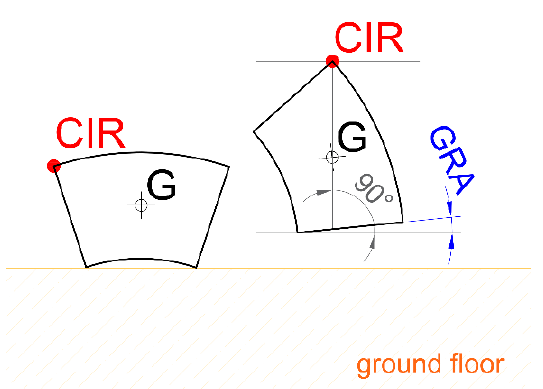
Figure 3. A block of the HLA: base supported ( left ) and suspended with respect to the Center of Instant Rotation (CIR), in stable equilibrium ( right ).